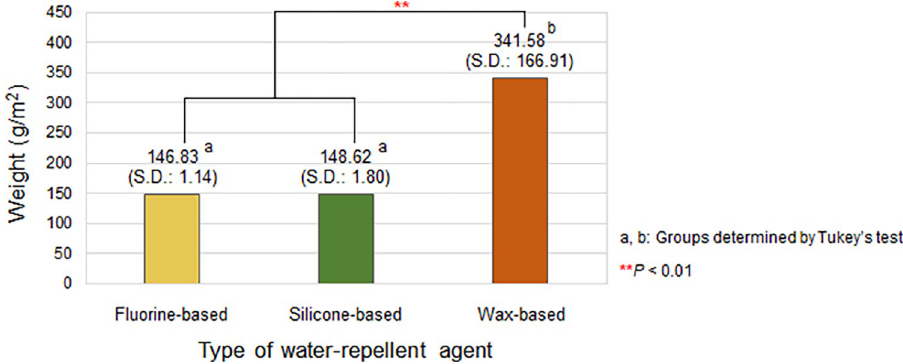
Fig 2. Weight of the cotton woven fabric according to the type of water-repellent agent. The result is the average weight of the fabrics of all numbers of coating layers under each water-repellent agent condition.